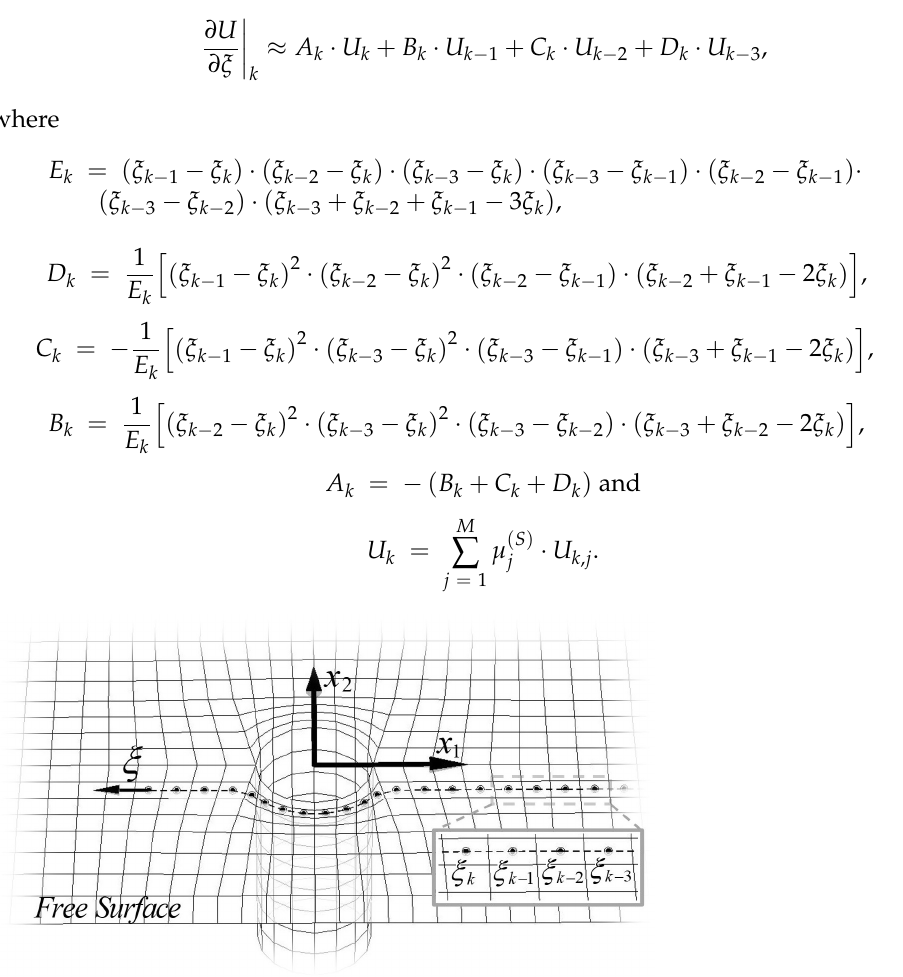
Figure 3. Indicative sparse mesh of the free surface boundary along with a cylindrical scatterer, highlighting the ξ -direction.